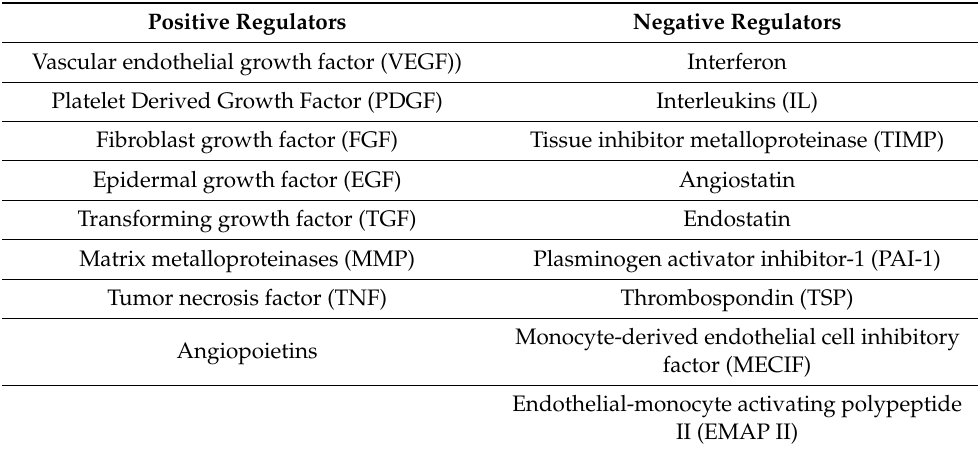
Table 1. Regulation of proliferation and survival of endothelial cells